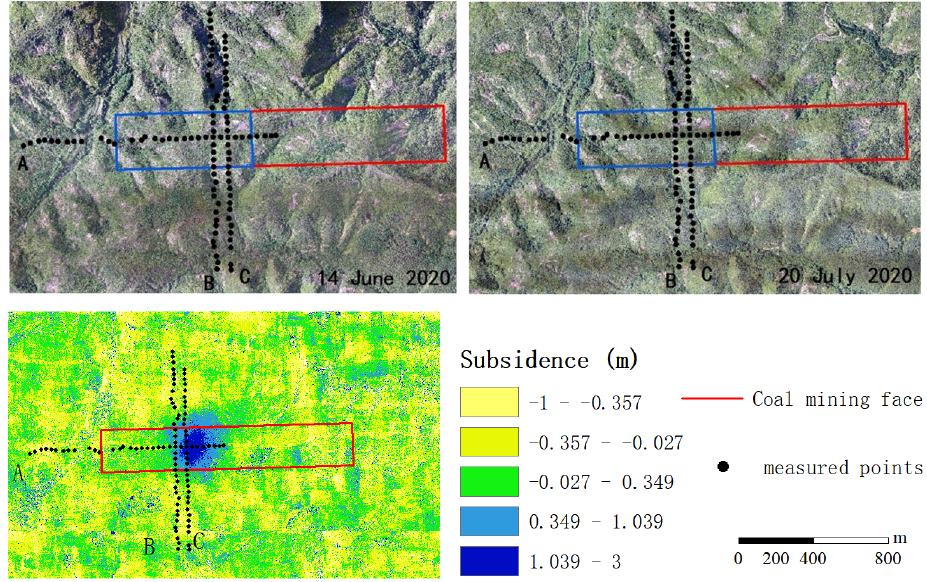
Figure 5. Subtraction of DEM maps from two different times as taken from a UAV.